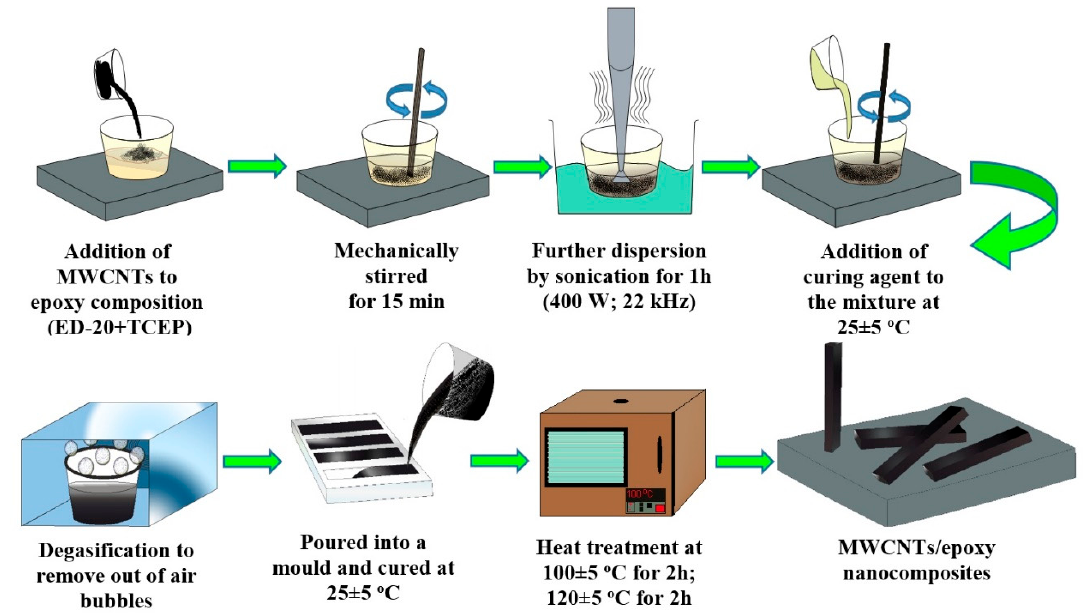
Figure 2. Schematic illustration for the preparation process of MWCNTs/epoxy nanocomposites.